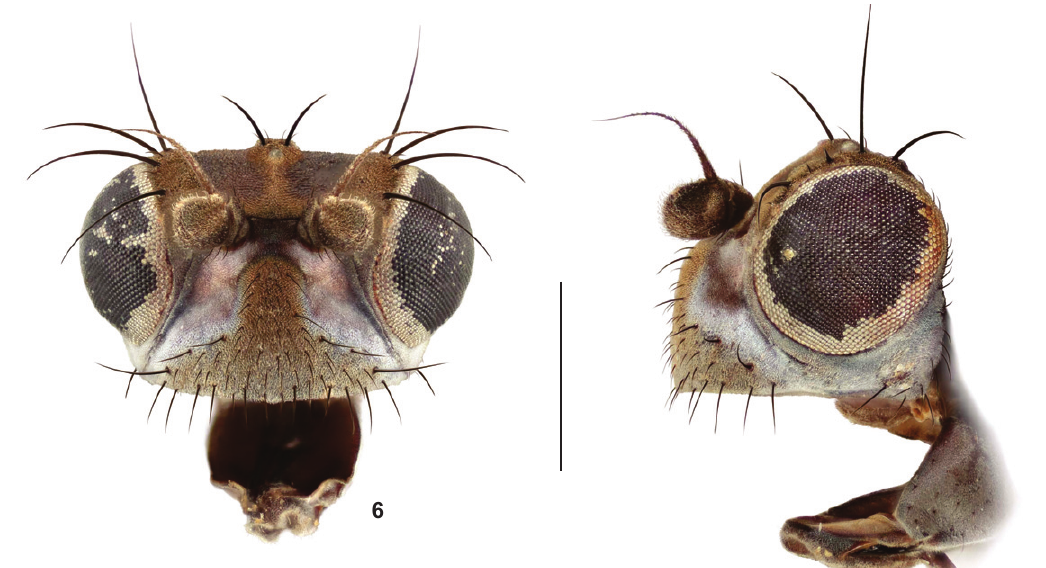
Figures 6-7. Scatella ( Scatella ) plaumanni sp. nov. , Brazil, Santa Catarina: Nova Teutônia: (6) head, anterior view; (7) same, lateral view. Scale bar: 0.5